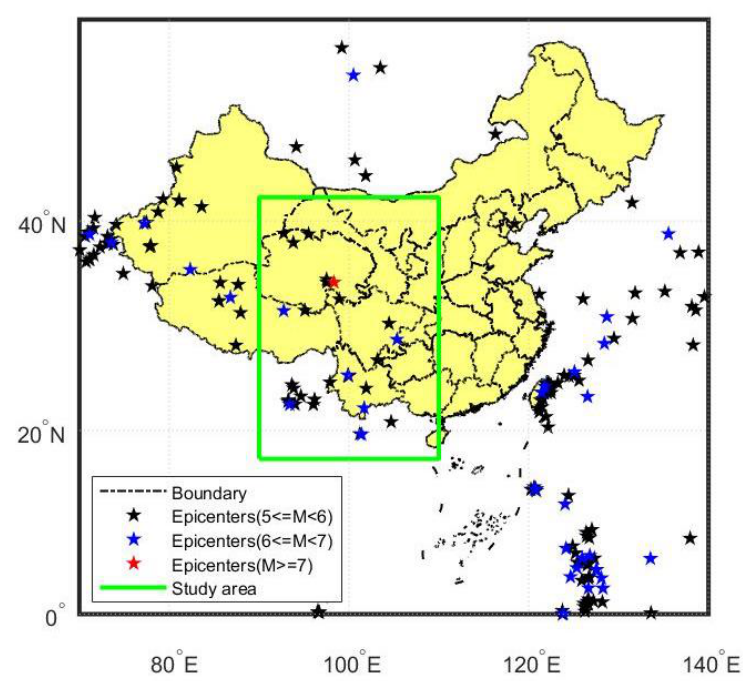
Figure 1. The epicenters in China and the surrounding area from 2020 to 2021.